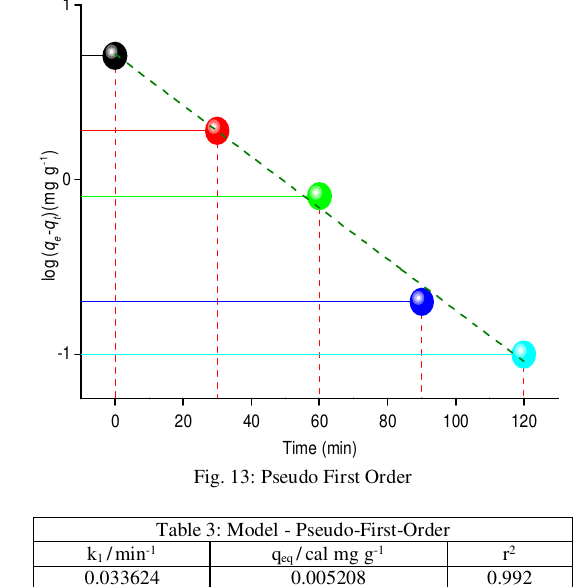
Fig. 13: Pseudo First Order Table 3: Model - Pseudo-First-Order k 1 / min -1 q eq / cal mg g